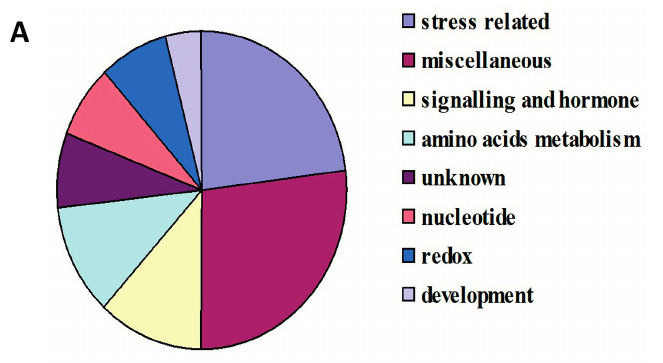
Figure 3. Stress response analyses of OsB12D1 . ( A ) Functional categorization of the OsB12D1 coexpression proteins, the detailed coexpression information is presented in the Table S2; ( B ) Heat maps of OsB12D1 response to different stresses. OsB12D1